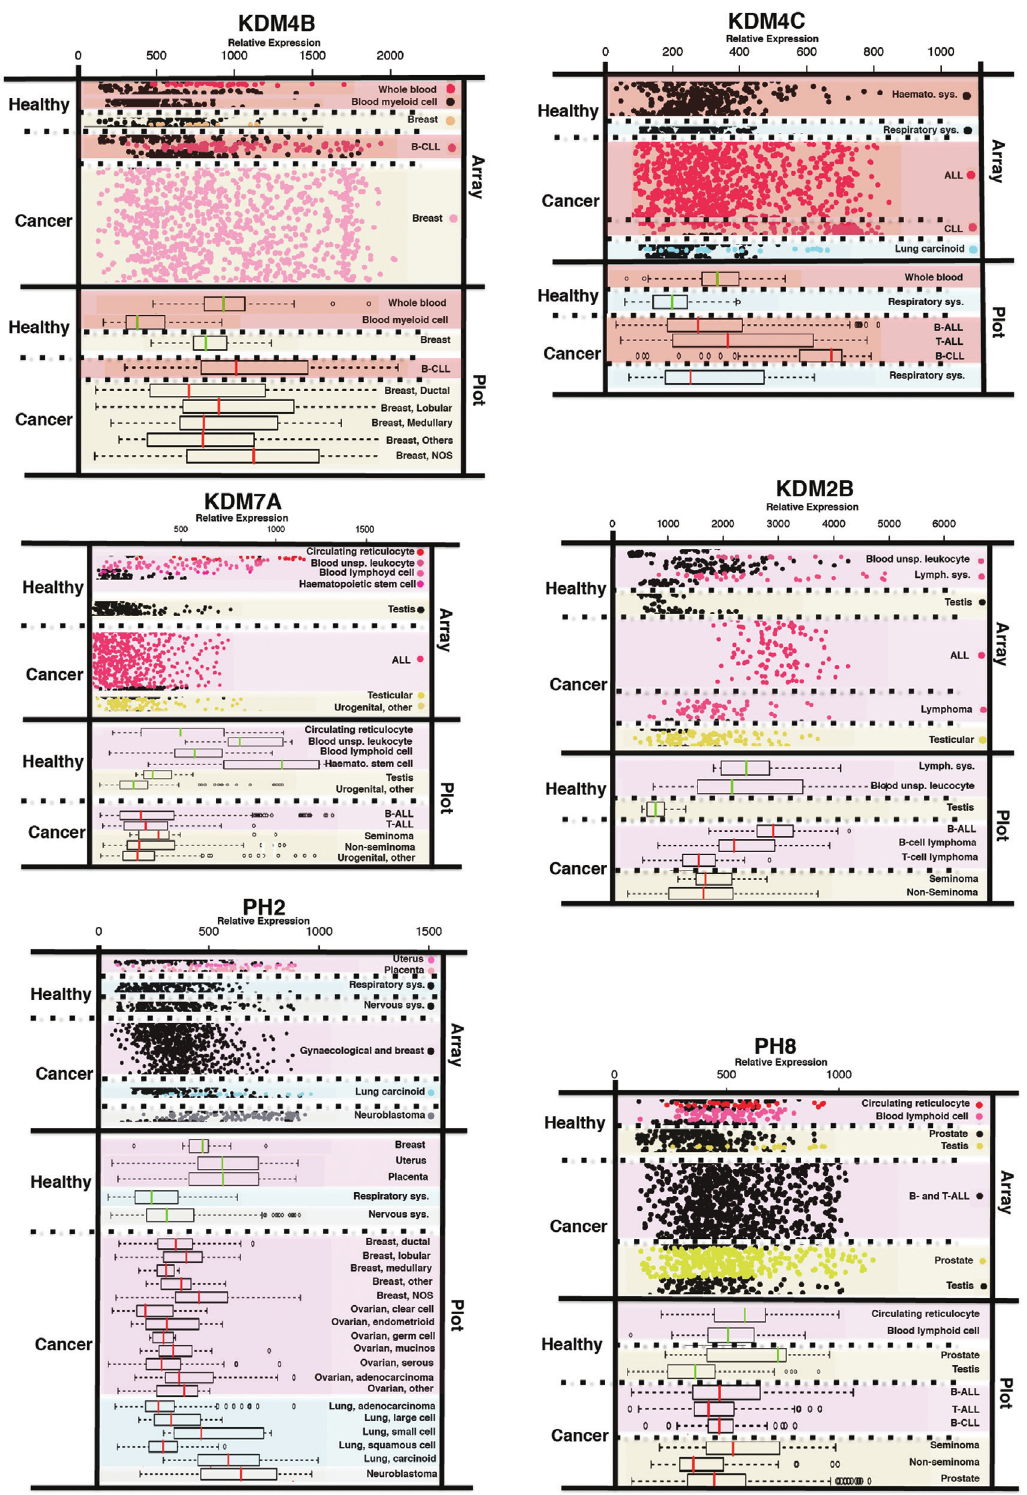
Figure 3 Significant variations in mRNA expression levels of some JmjC proteins in healthy vs. cancer patient samples array (based on the Genesapiens.org database). Dots are representative of individual array value. Box plots represent the data integration of individual